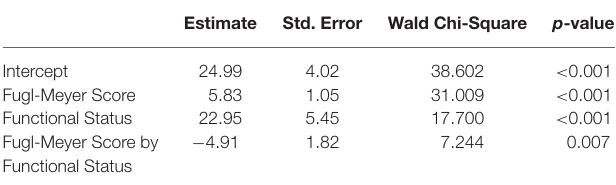
TABLE 3 | Predicting change in Fugl-Meyer Score over time by functional status. Estimate Std. Error